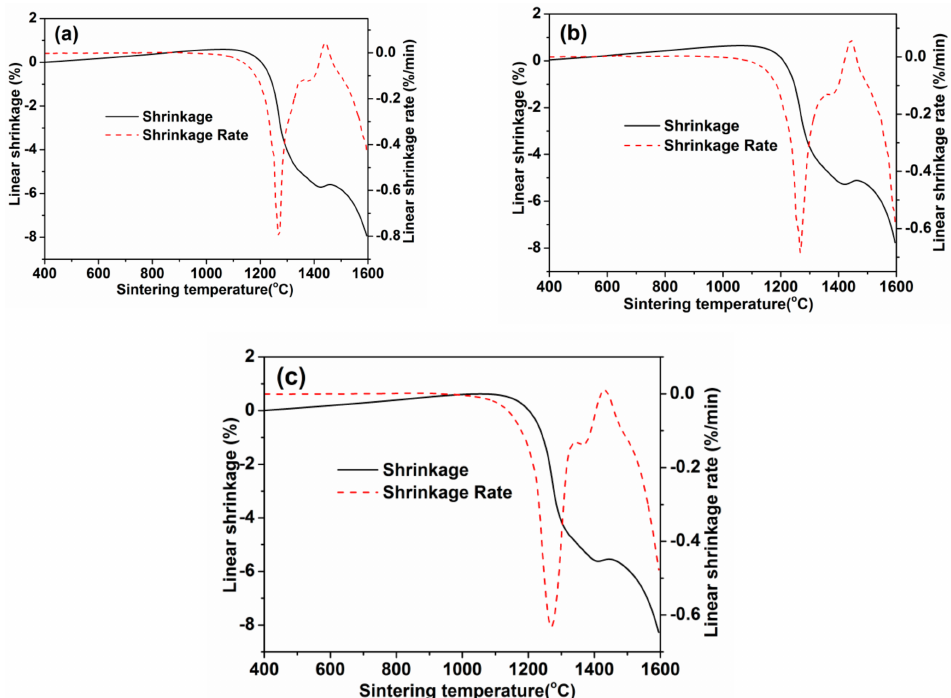
Figure 4. Shrinkage and shrinkage rate during constant heating rate (10 ◦ C/min) sintering of the